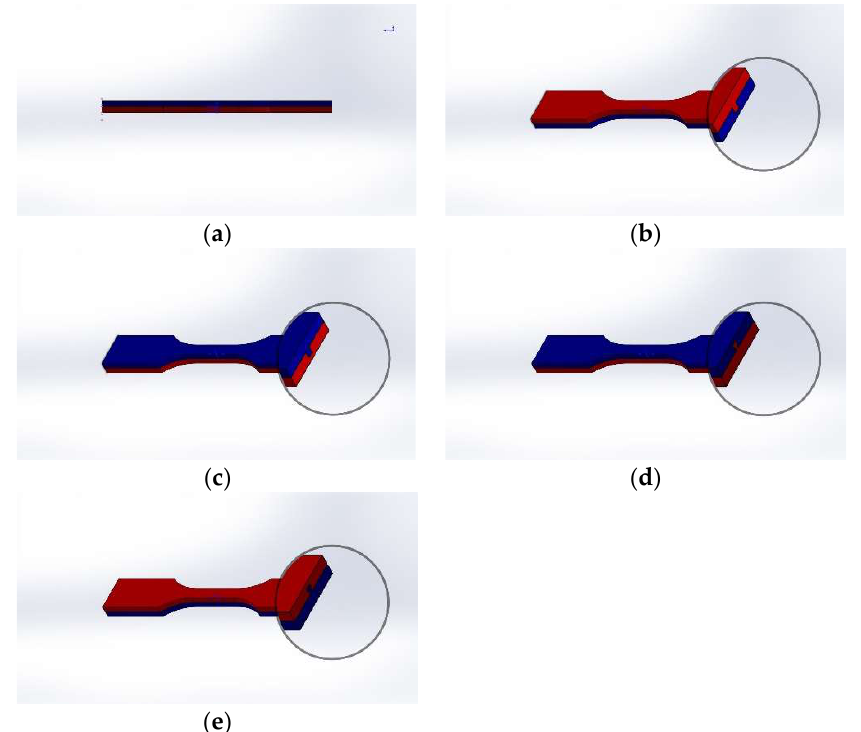
Figure 3. CAD design for finished HYM samples: ( a ) NJ series; ( b ) MC 50; ( c ) FC 50; ( d ) MT 50; and ( e ) FT 50. Red represents the FDM preform, and blue the IM subs t rate.